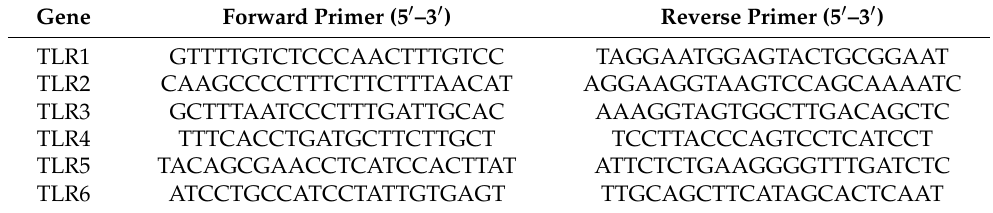
Table 1. The primer sequences of the genes for mRNA expression quantification by qPCR.